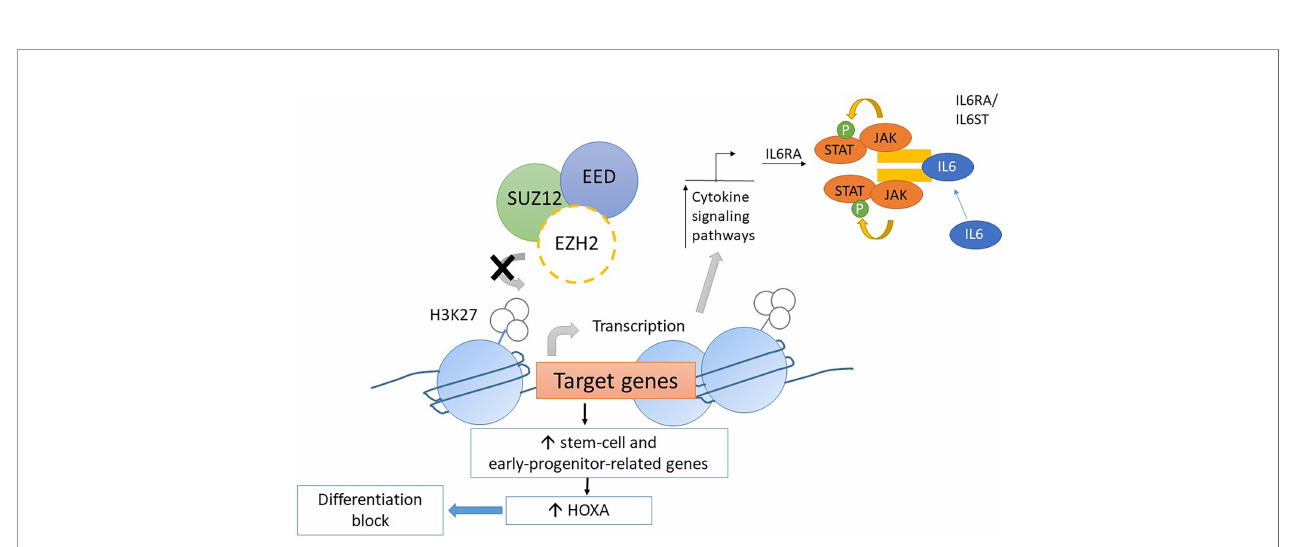
FIGURE 4 | Mechanism of leukemogenesis due to loss-of-function mutation in EZH2 . Loss-of-function mutations in EZH2 increase transcription of stem-cell and early-progenitor related genes including HOXA . It results into differentiation block of thymocytes. Moreover, the transcription of IL6RA is increased due to loss-of- function EZH2 mutations. Thus, the expression of IL6 receptor is increased and causes hyperresponsiveness to IL6 which results into hyperactivation of